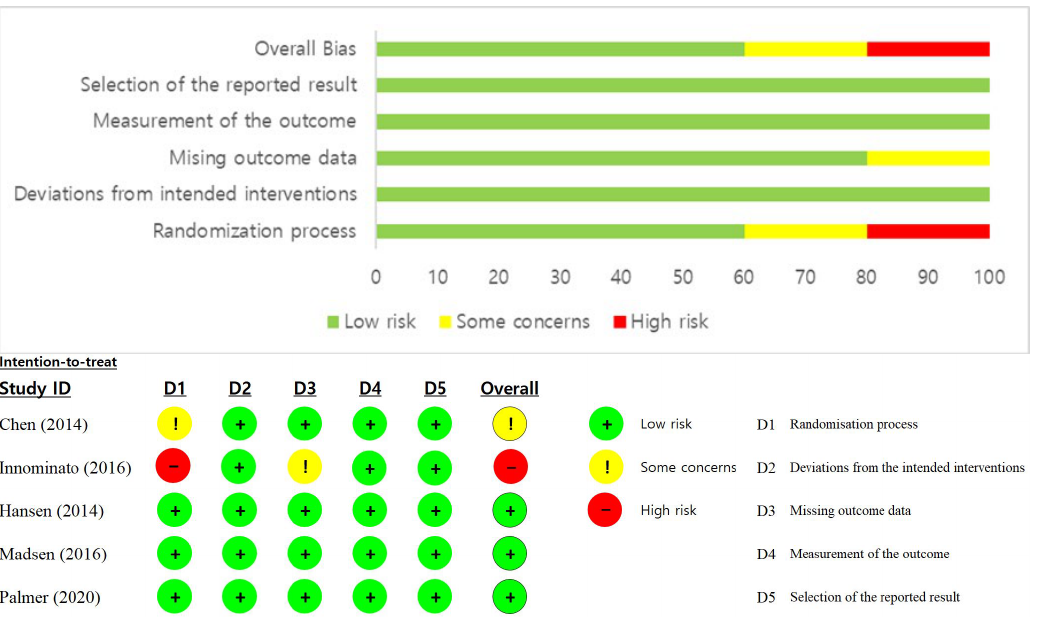
Figure 2. Risk of bias level for the included studies